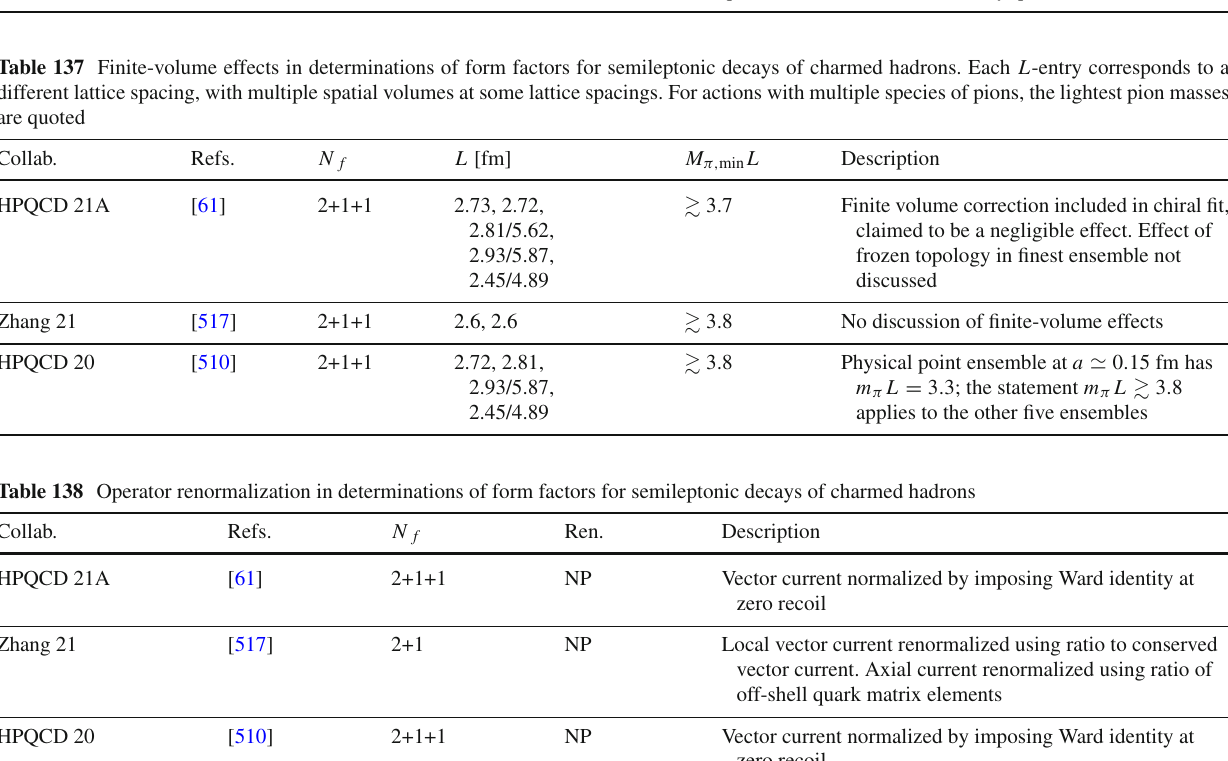
Vector current normalized by imposing Ward identity at zero recoil